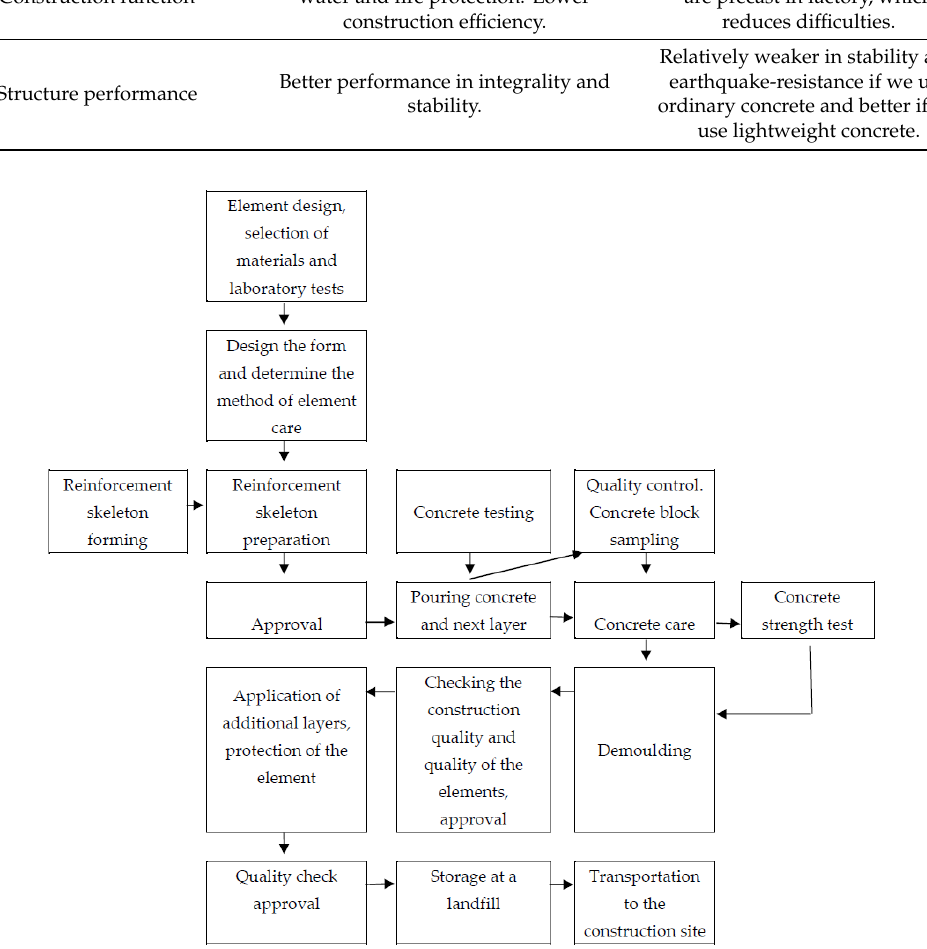
Figure 1. Process of manufacturing of prefabricated wall elements [30] .